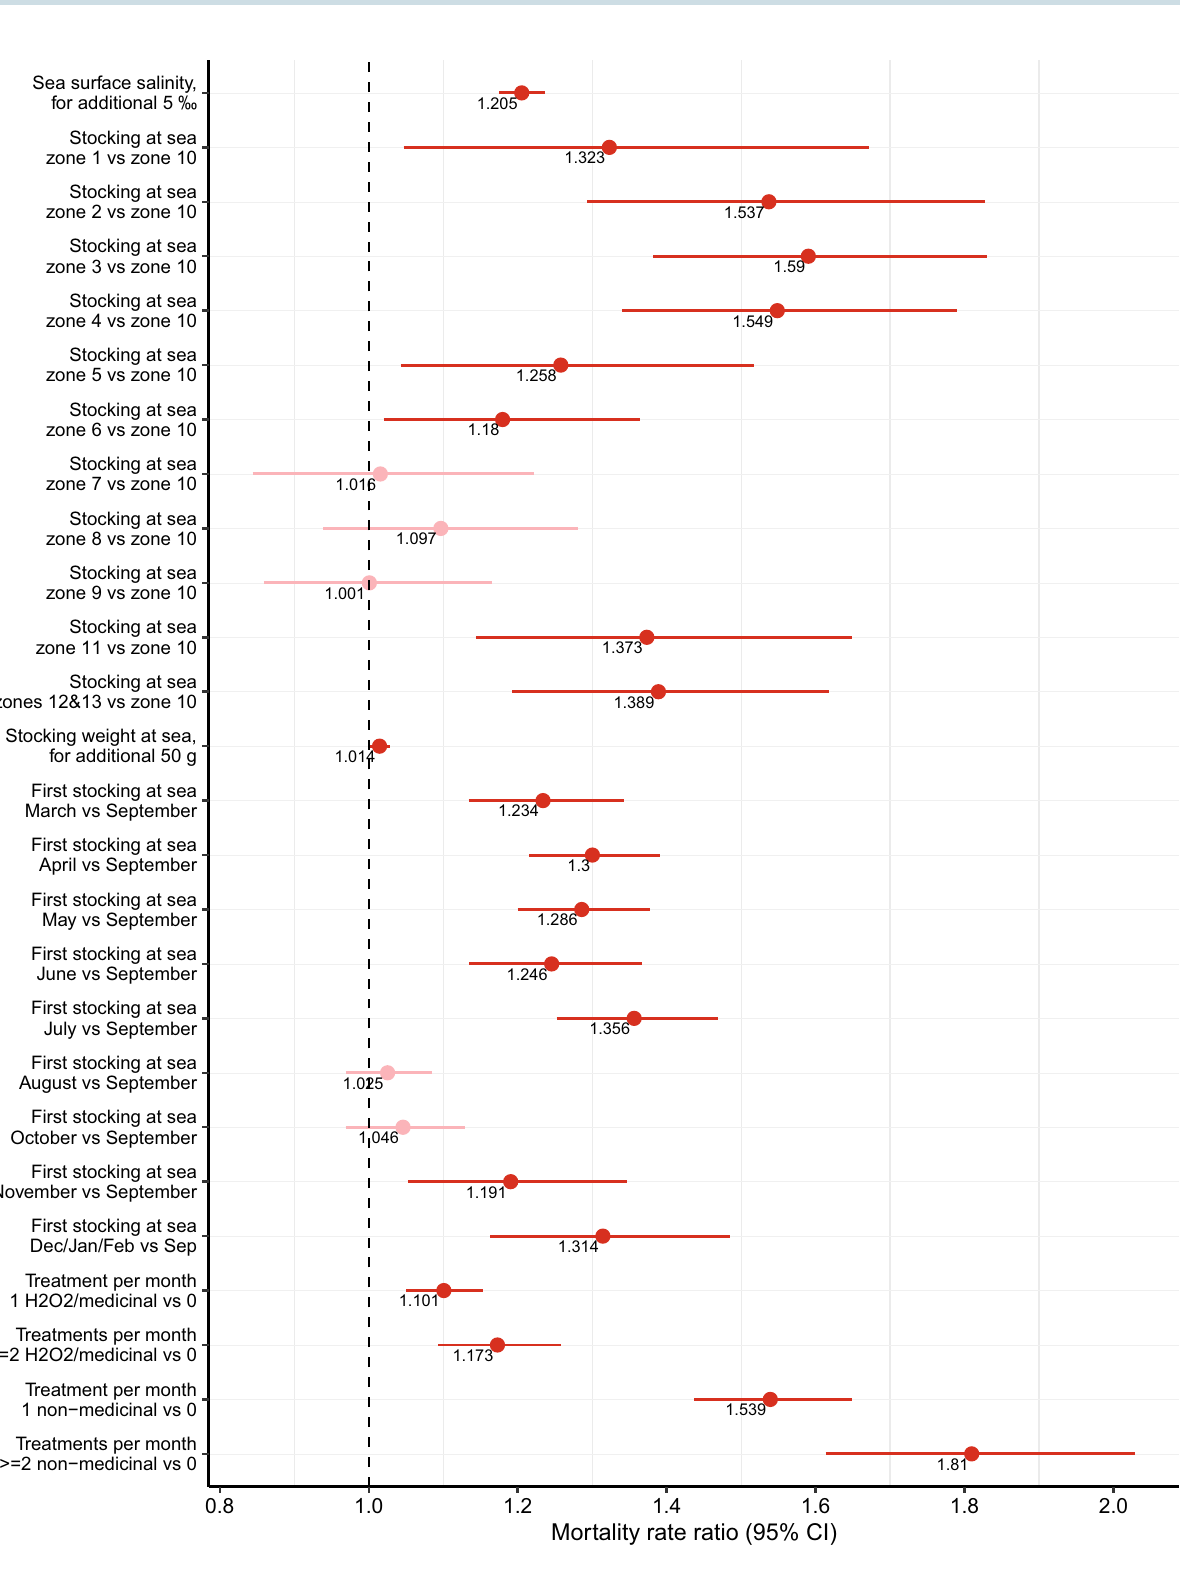
Figure 3. Mortality rate ratio plot with the determinants of baseline mortality in farmed Atlantic salmon. Results of other determinants added as polynomial terms in our mortality model are shown in Figs. 4 and 5. This figure was generated using the Tidyverse 46 package in R 47